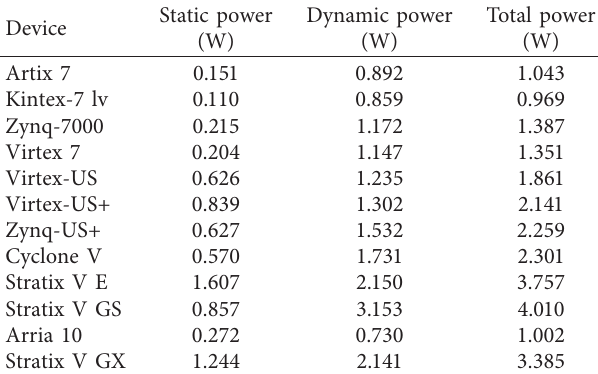
Table 7: Power consumption for Xilinx and Intel FPGAs. Device